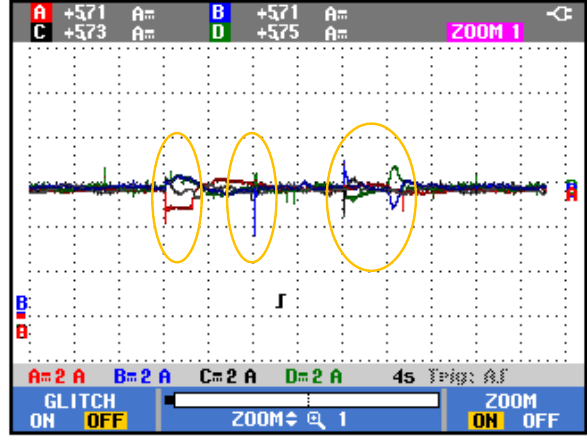
Figure 20. DGUs output currents during mixed voltage attacks.